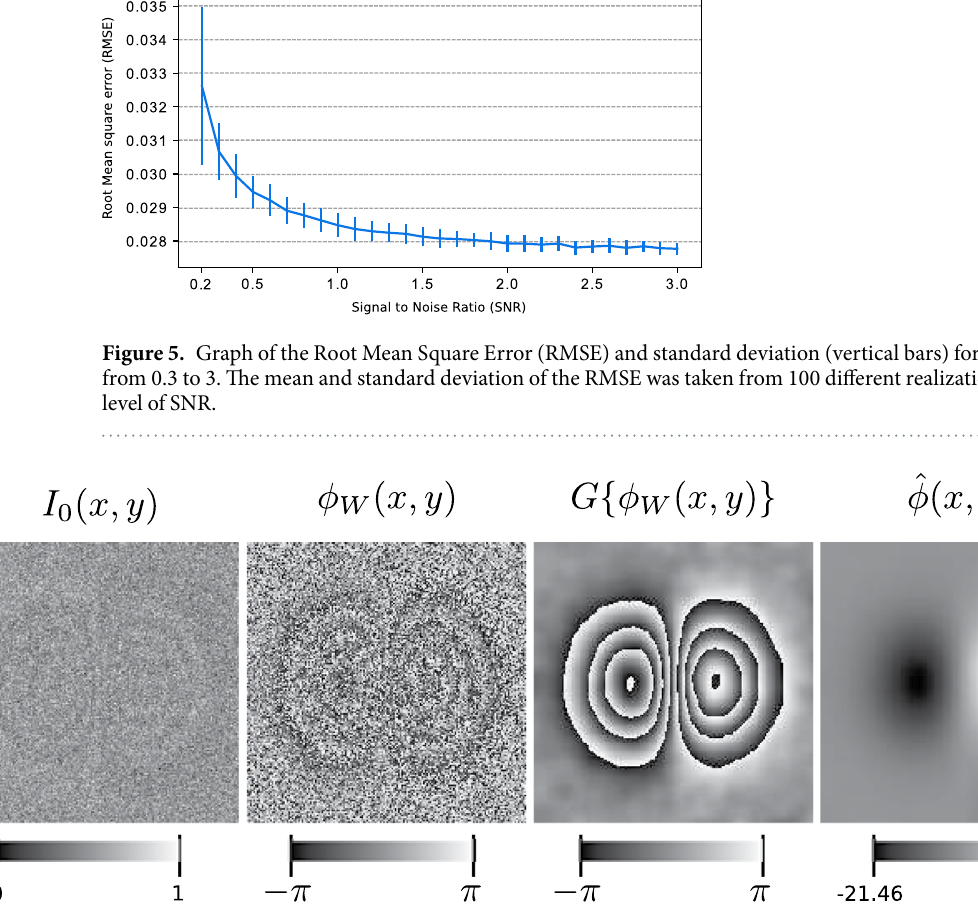
Figure 6. Result obtained by using the four interferograms of a four-step PSI sequence. The first image is the first fringe pattern of the 4-steps sequence; the second image is the wrapped phase obtained from the 4-step algorithm; the third image is the filtered wrapped phase we obtain, denoted here as G { φ W ( x , y )}, and the fourth image is the corresponding unwrapped phase. The signal to noise ratio of interferograms is SNR = 0.08. The color bars indicate the dynamic range of the